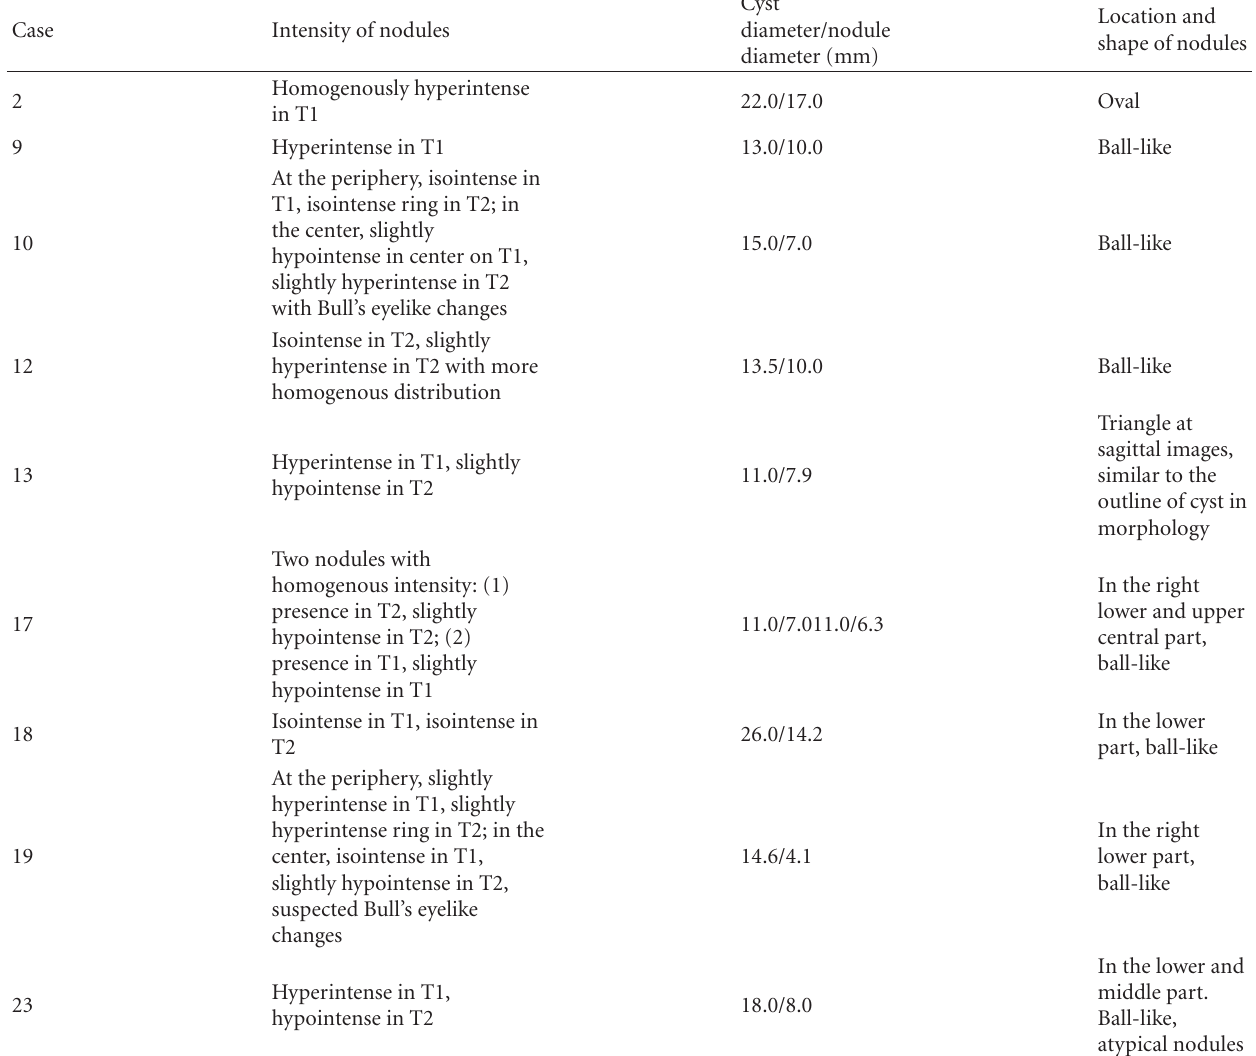
Table 2: Features of intracystic nodules on MRI in RCC